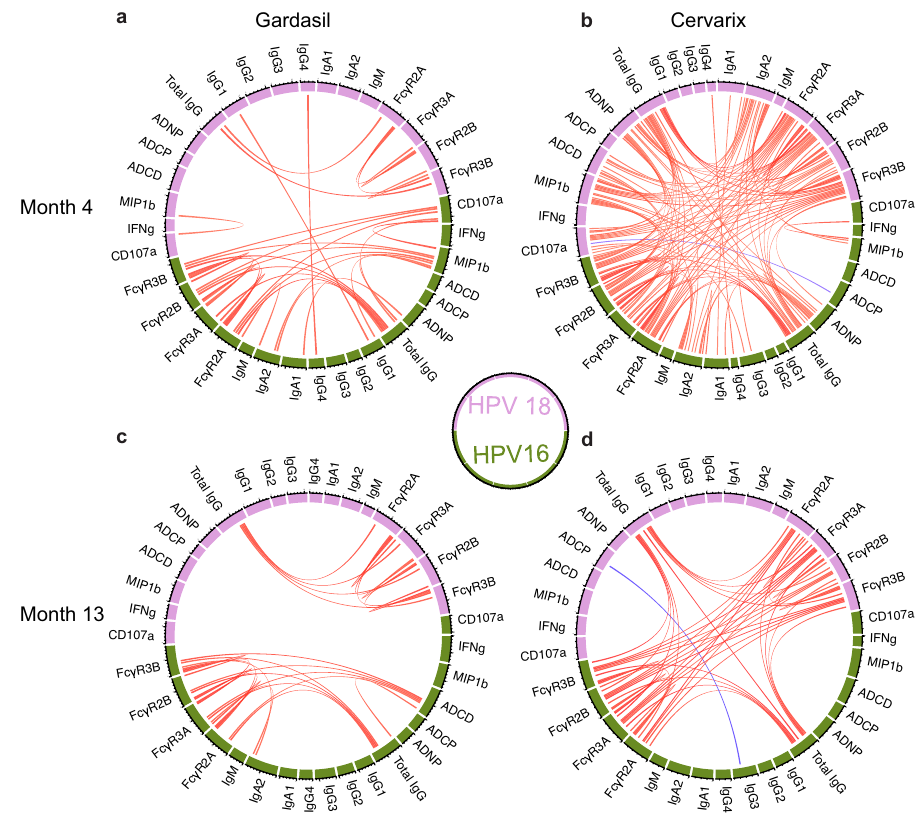
Fig. 3 Correlation between immune responses at month 4 and 13. a – d Chord diagrams showing Spearman correlation (r) between features at month 4 and 13. Red and blue represent positive and negative correlation coef fi cient, respectively, and darker color represents a higher absolute value of the correlation coef fi cient. All shown correlations are those with | r | >0.7 and p < 0.01 after multiple test correction with the Benjamini-Hochberg procedure for all comparisons between features from each timepoint and each vaccine type. ADCD antibody-dependent complement deposition, ADNP antibody-dependent neutrophil phagocytosis, ADCP antibody-dependent cellular cross-strain coordination compared to Cervarix ® (Fig. 4a-c). On the other hand, at month 13, Cervarix ® recipients showed an enhanced IgG-driven correlation with FcR binding within and across strains (Fig. 4b). Differences in correlation across the 2 vaccines became less pronounced by month 13 as Gardasil ® recipients gained more cross-strain coordination, suggesting that additional doses may have shifted Gardasil ® immunity towards a more balanced pro fi le (Fig. 4a, c). Yet, some differences strongly persisted at month 13 across the 2 vaccine responses, most of which were related to cross-strain correlation differences, that were weaker for Gardasil ® compared to Cervarix ® induced pro fi les.